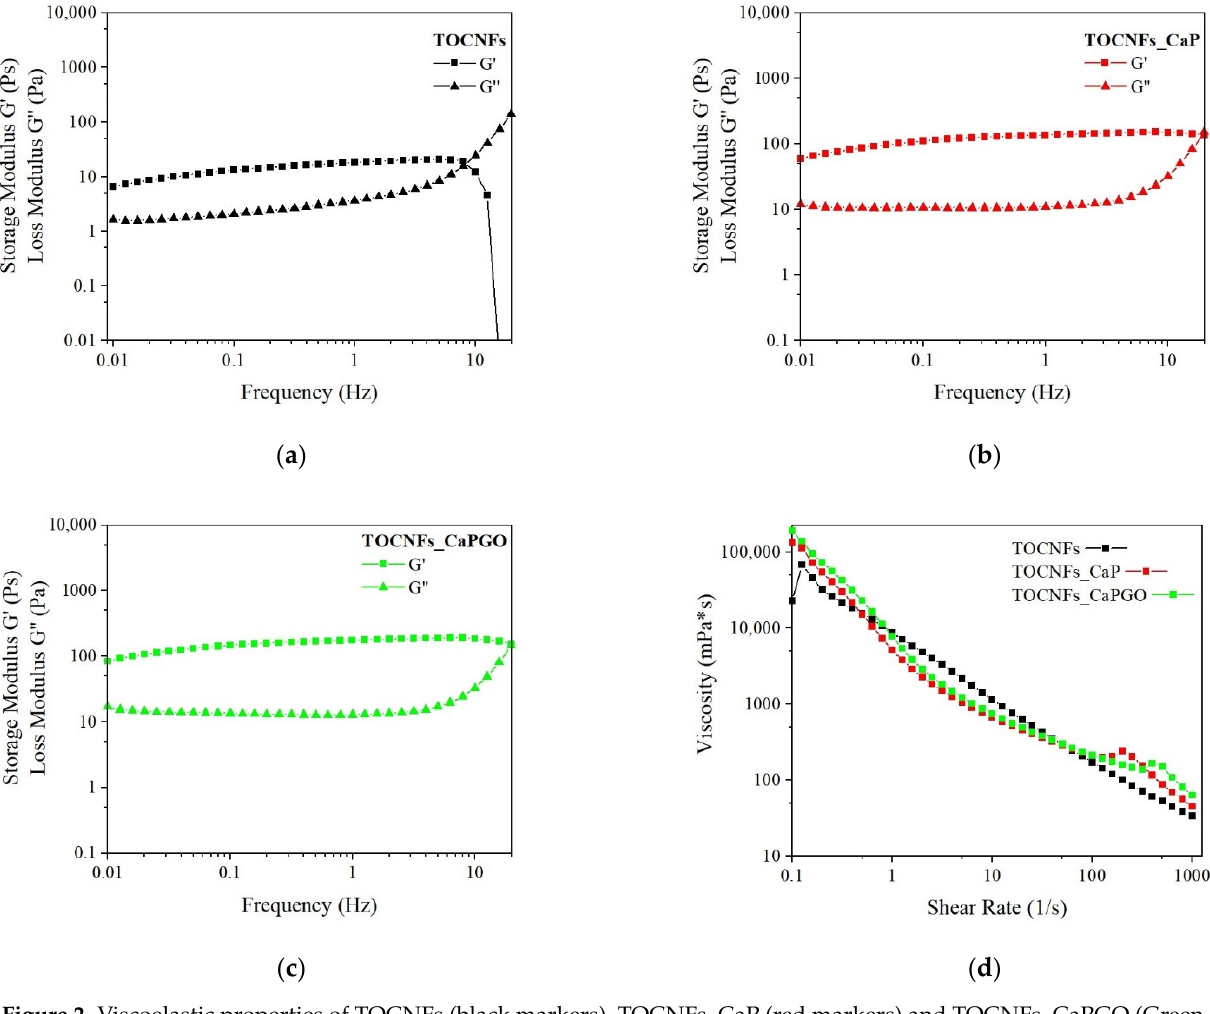
Figure 2. Viscoelastic properties of TOCNFs (black markers), TOCNFs_CaP (red markers) and TOCNFs_CaPGO (Green markers) samples. ( a – c ) Dynamic frequency sweeps (20 °C) of composites (10% strain rate); ( d ) Dynamic shear rate sweep (0.1 to 1000 s − 1 ).